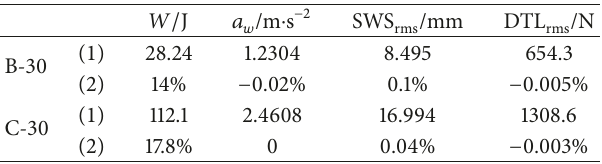
Table 2: Simulation results with mode-switching of the supercapac-